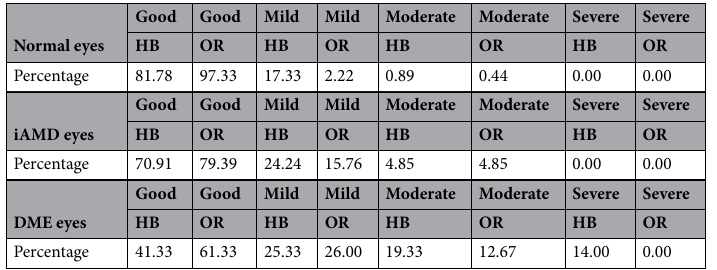
Table 1. Percentage of segmentation error gradings in normal eyes, in iAMD eyes and in eyes with DME using the proprietary (HB) and the cross-platform (OR) softwares.